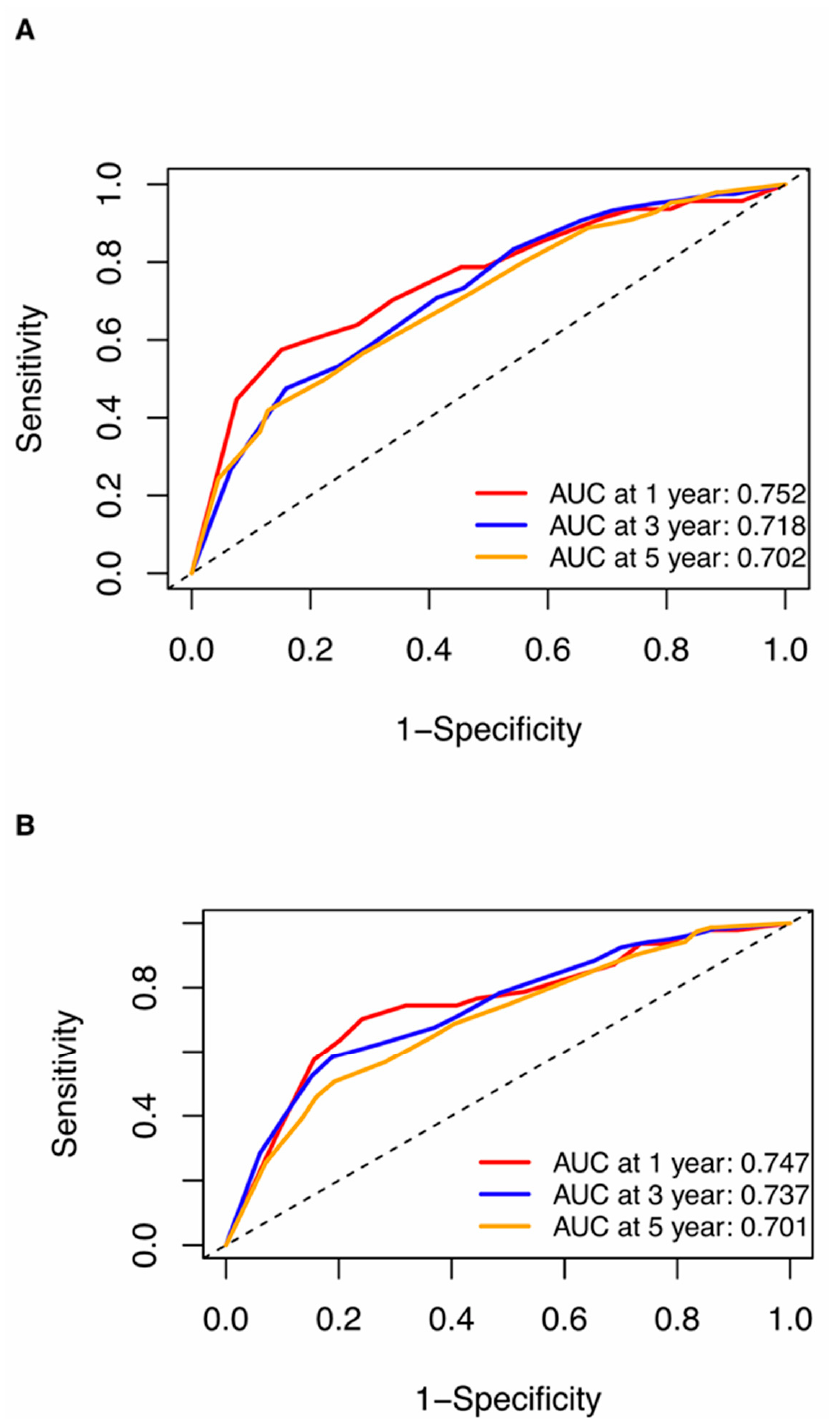
Figure 5. ROC curves for ( A ) the pre-NAC nomogram model and ( B ) the post-NAC nomogram model to predict the probability of 1-, 3-, and 5-year DFS in the primary cohort. Dashed-line: reference line. Abbreviations: ROC, receiver operating characteristic; DFS, disease-free survival; pCR, pathologic complete response; NAC, neoadjuvant chemotherapy; AUC, area under the curve.